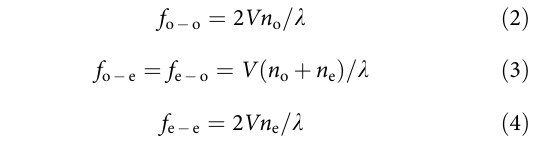
The reflected (beam 1) and scattered (beam 2) probe beams interfere in the photodetector ( E r . d E s ) to give rise to Brillouin